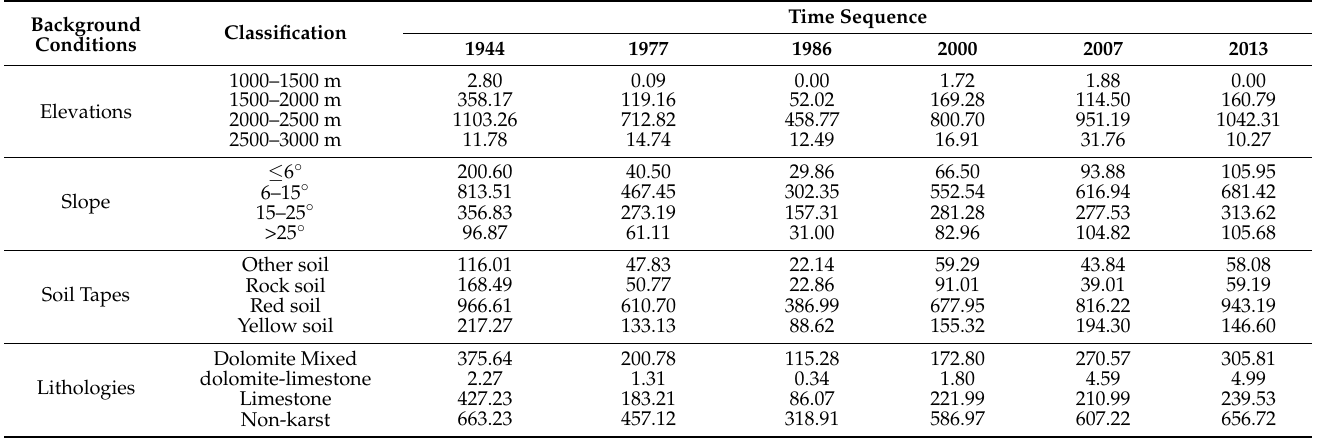
Table 2. The distribution and change information of forest landscape under various natural back- ground conditions during different historical stages (unit: km 2 ). (We constructed this table